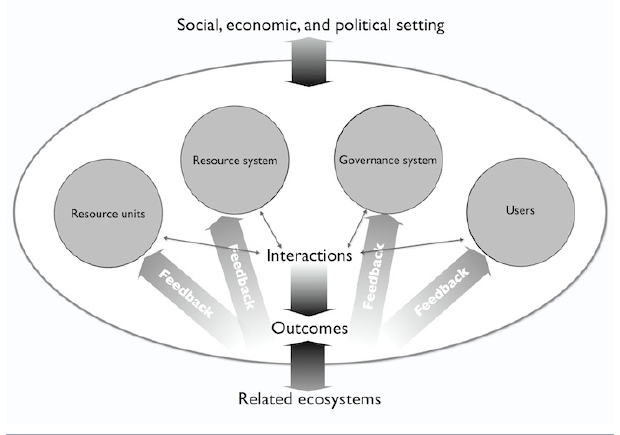
Fig. 1 . Conceptual framework of a social–ecological system, as proposed by Ostrom (2009).